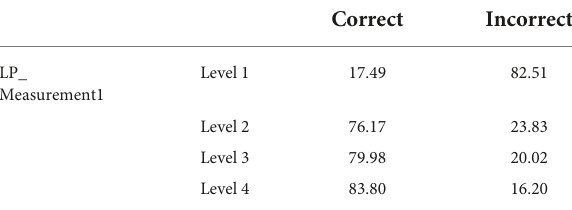
TABLE 4 Conditional probabilities for Task 7 at the first measurement (% Probability).